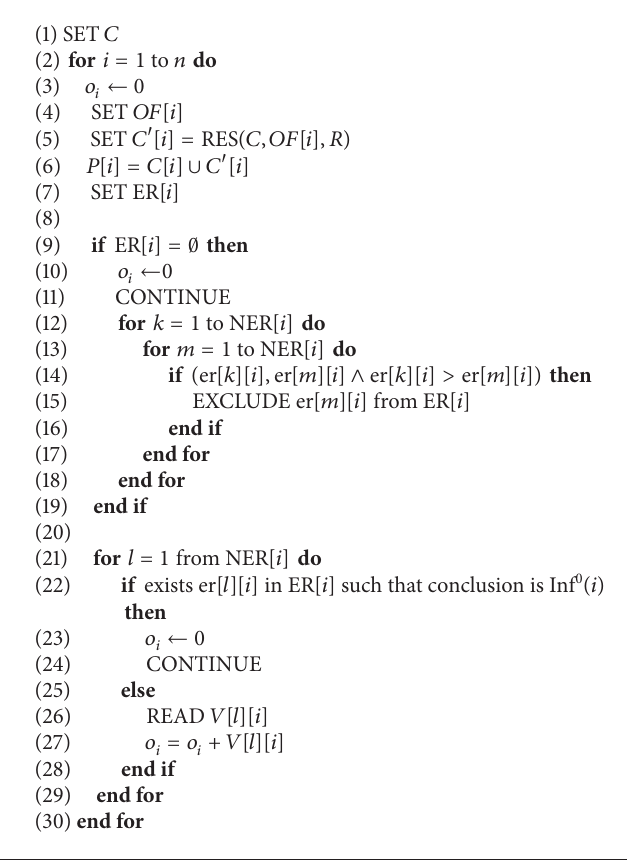
Algorithm 1: Algorithm of security attributes evaluation.